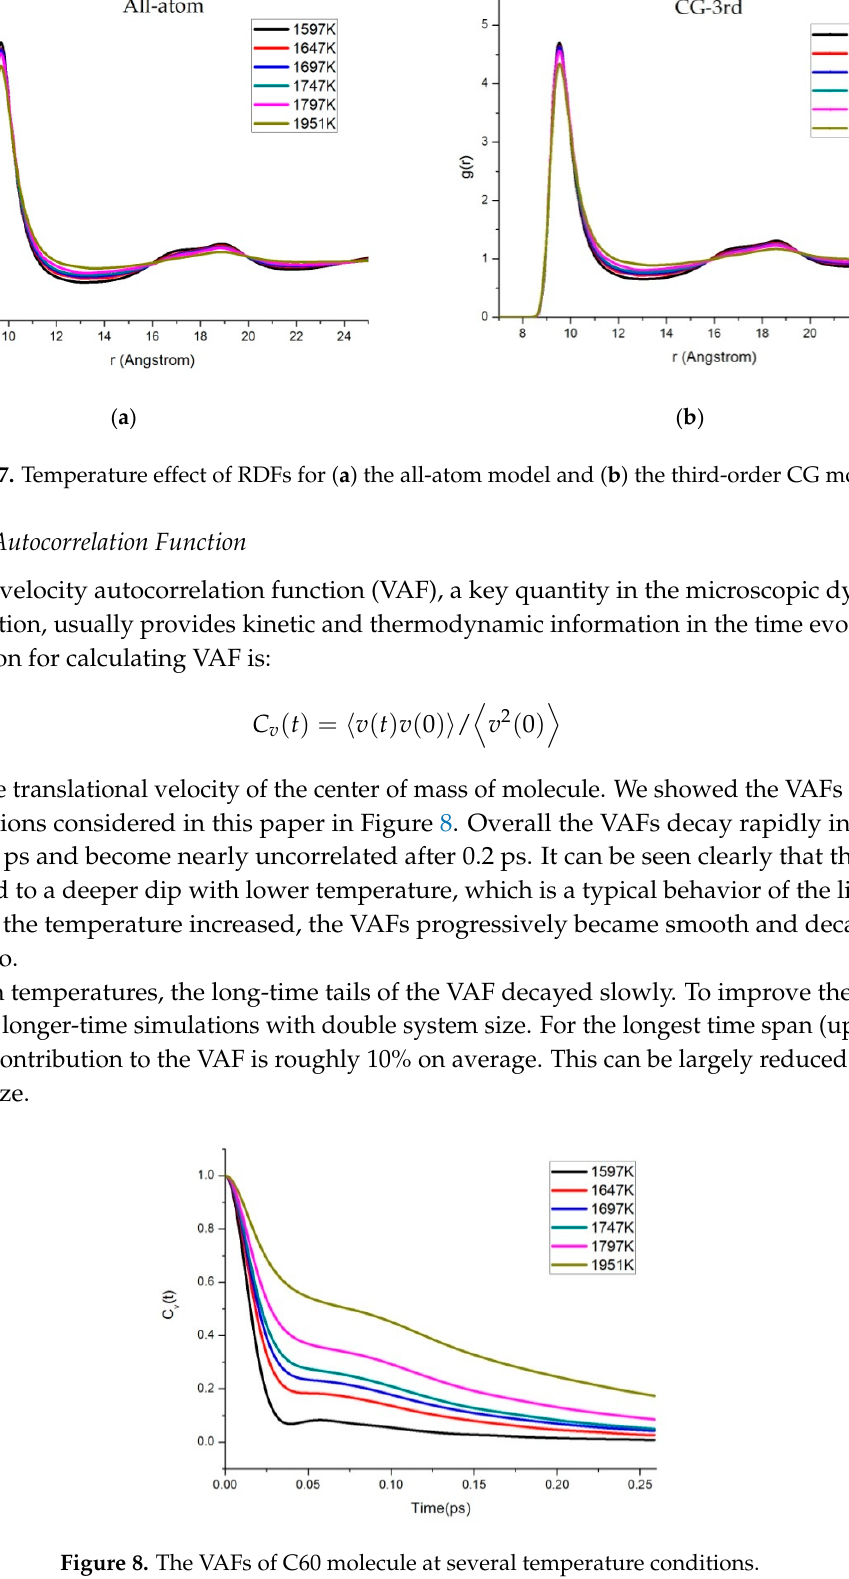
Figure 8. The VAFs of C60 molecule at several temperature conditions.